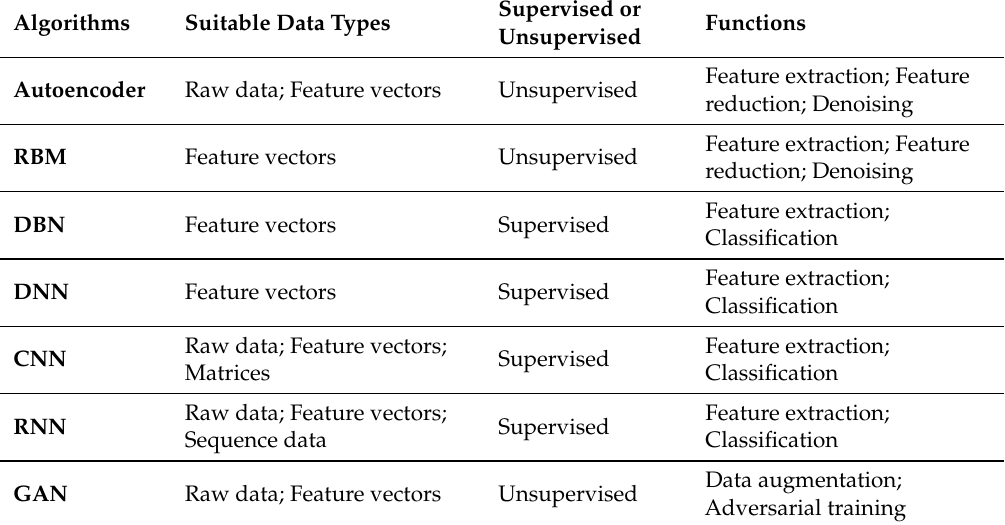
Table 4. Comparison of various deep learning